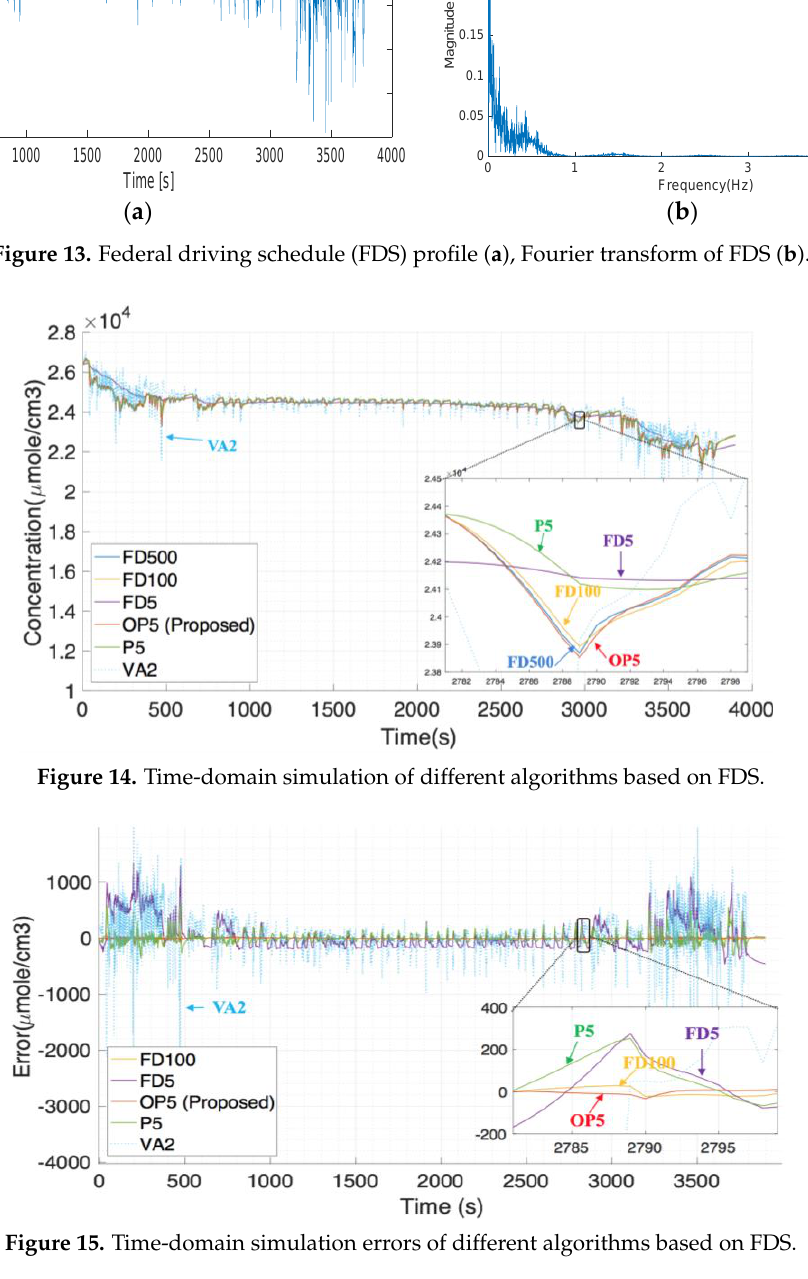
Figure 15. Time-domain simulation errors of different algorithms based on FDS.